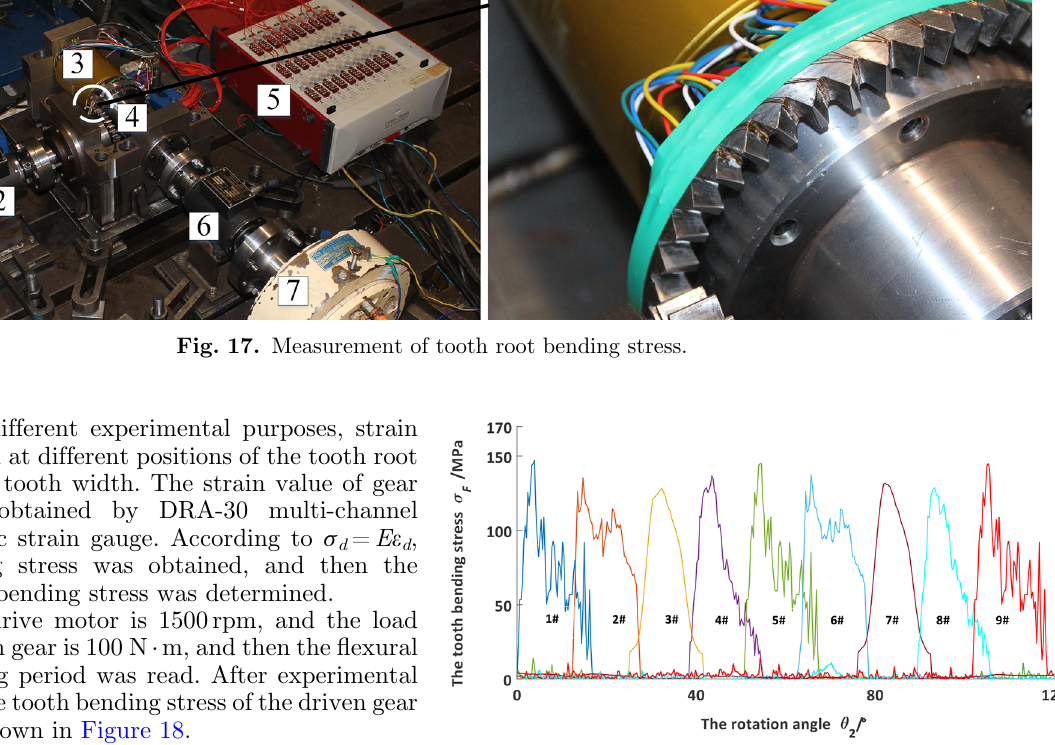
Fig. 18. Measurement results of tooth bending